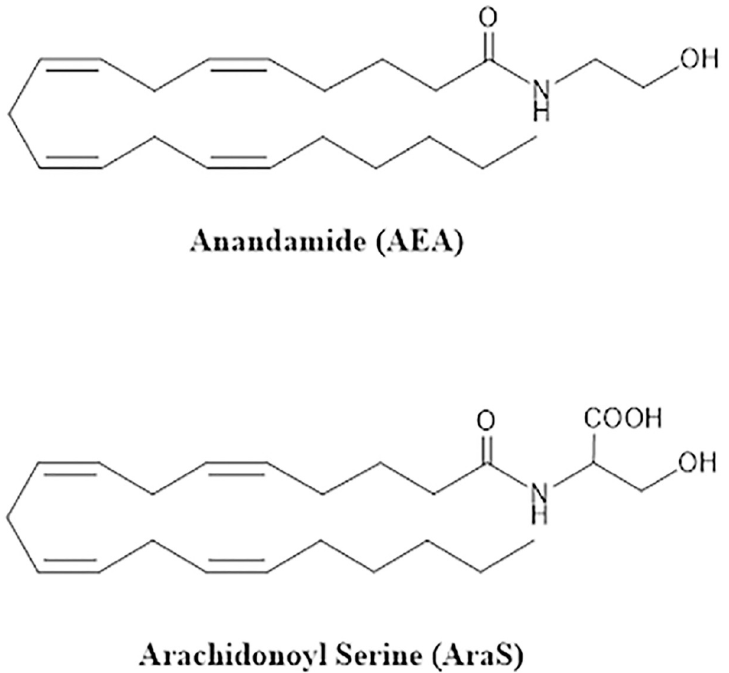
Fig 1. Structure of EC and EC-like